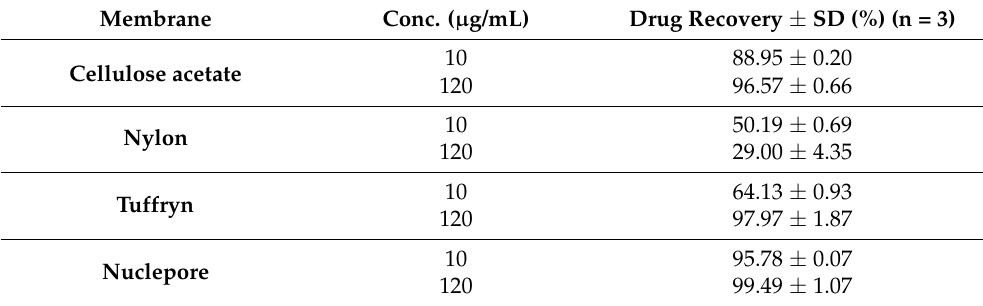
Table 4. Drug recovery from standard solutions after passing through different membranes.